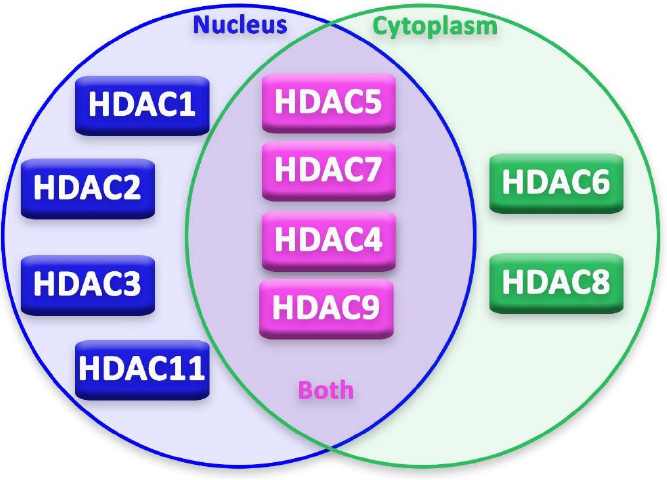
Figure 2. Localization of HDACs in the cell.